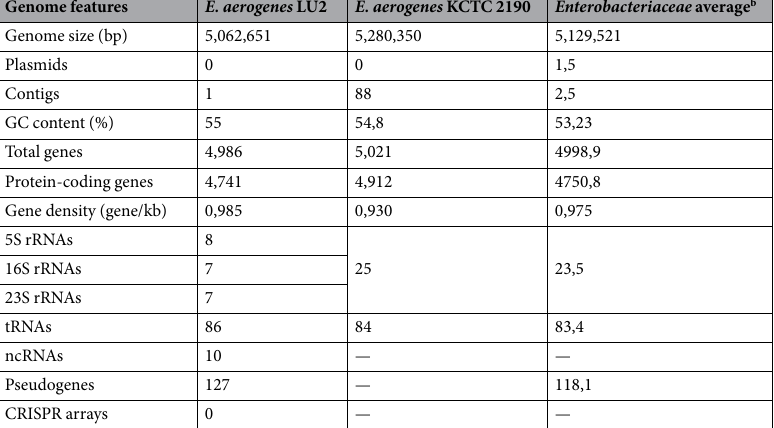
— — Table 1. General features of Enterobacter aerogenes LU2 genome compared to reference genome (KCTC 2190) and ten a complete Enterobacteriaceae genomes. “–”no data available. a Escherichia coli AIA39, K12, NRG857c strains, Citrobacter freundii CFNIH1, FDAARGOS73, CAV1321 strains, Raoultella ornithinolytica B6, S12, A14 strains, Enterobacter cloaceae ATCC13047 strain. b Data based on genome summary pages of NCBI GenBank